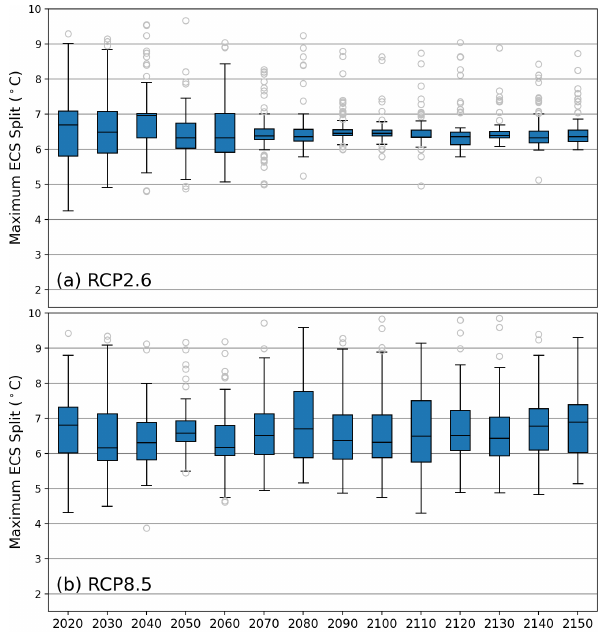
Figure 3. Distributions of the maximum equilibrium climate sensi- tivity (ECS) split value from each decision tree in the fitted random forests. Panel (a) depicts the maximum ECS split distributions in the RCP2.6 forests, and panel (b) depicts the maximum ECS split distributions in the RCP8.5 forests. The outliers are the data points less than Q1 − 1 . 5 · IQR or greater than Q3 + 1 . 5 · IQR, where Q1 is quartile 1, Q3 is quartile 3, and IQR is the interquartile range (Q3 − Q1). The blue boxes show the IQR, and the line within the IQR is the